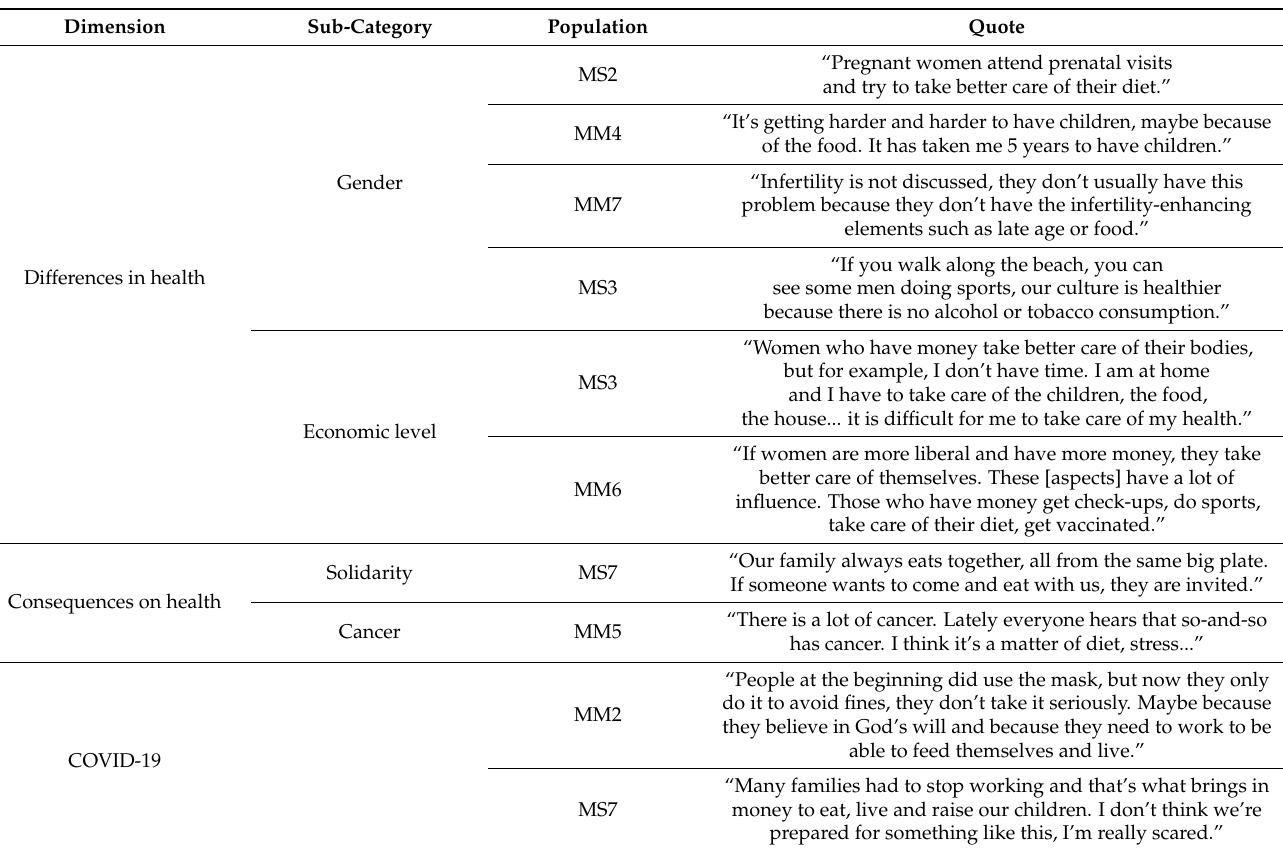
Table 6. Differences and consequences on health and the COVID-19 pandemic: Senegalese and Moroccan women’s